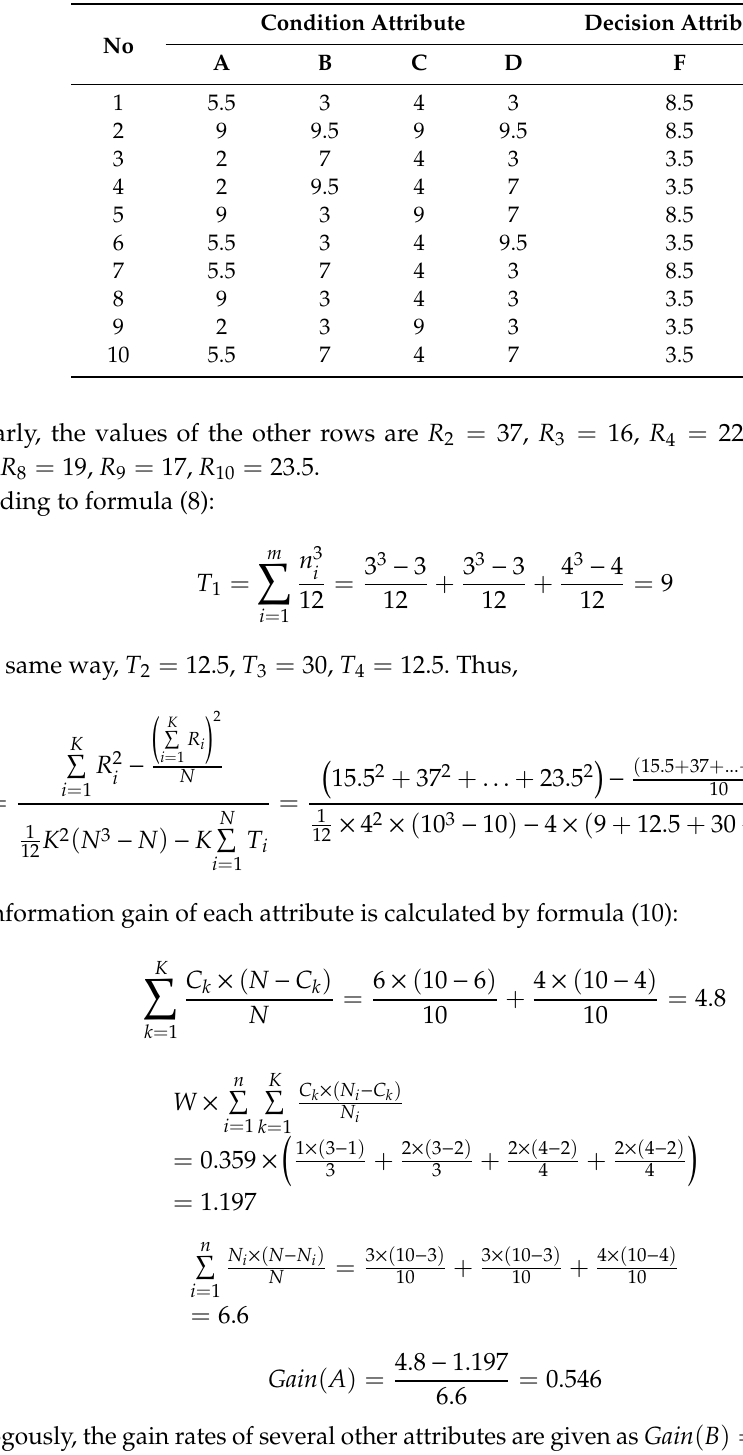
Table 4. Grade evaluation